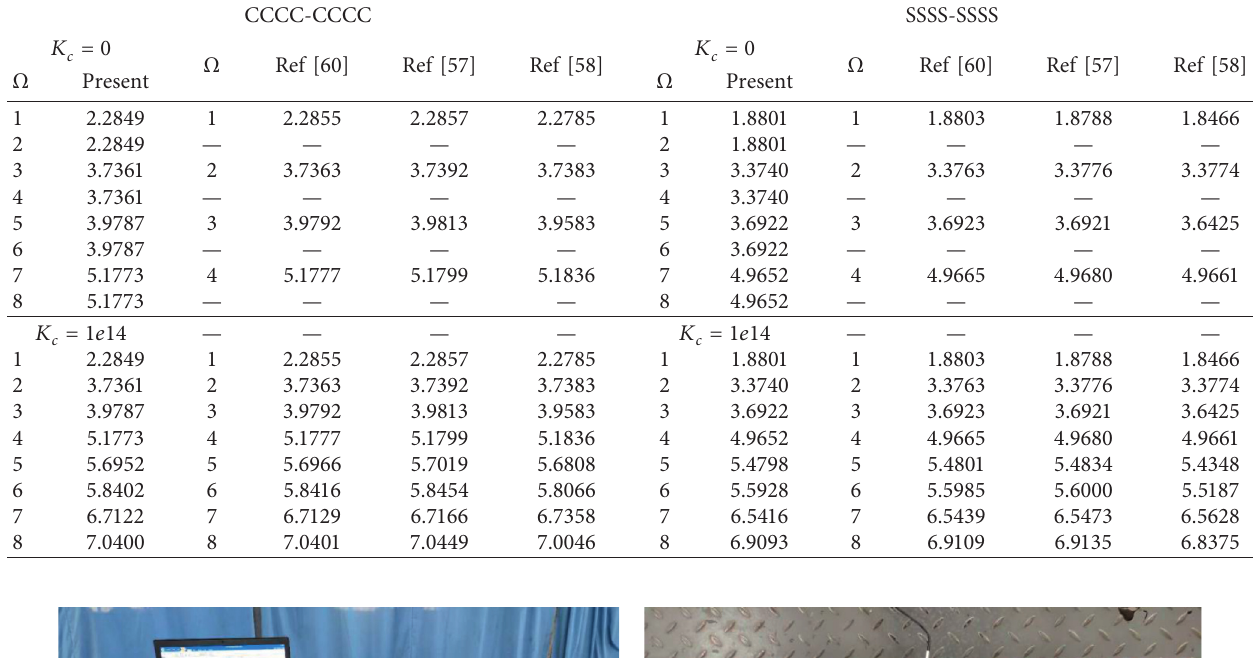
Table 3: Comparison of the natural frequency parameters Ω for an [45 ° /60 ° /45 ° /60 ° ] LCDPS with various conditions Ω � ω a 2 / π 2